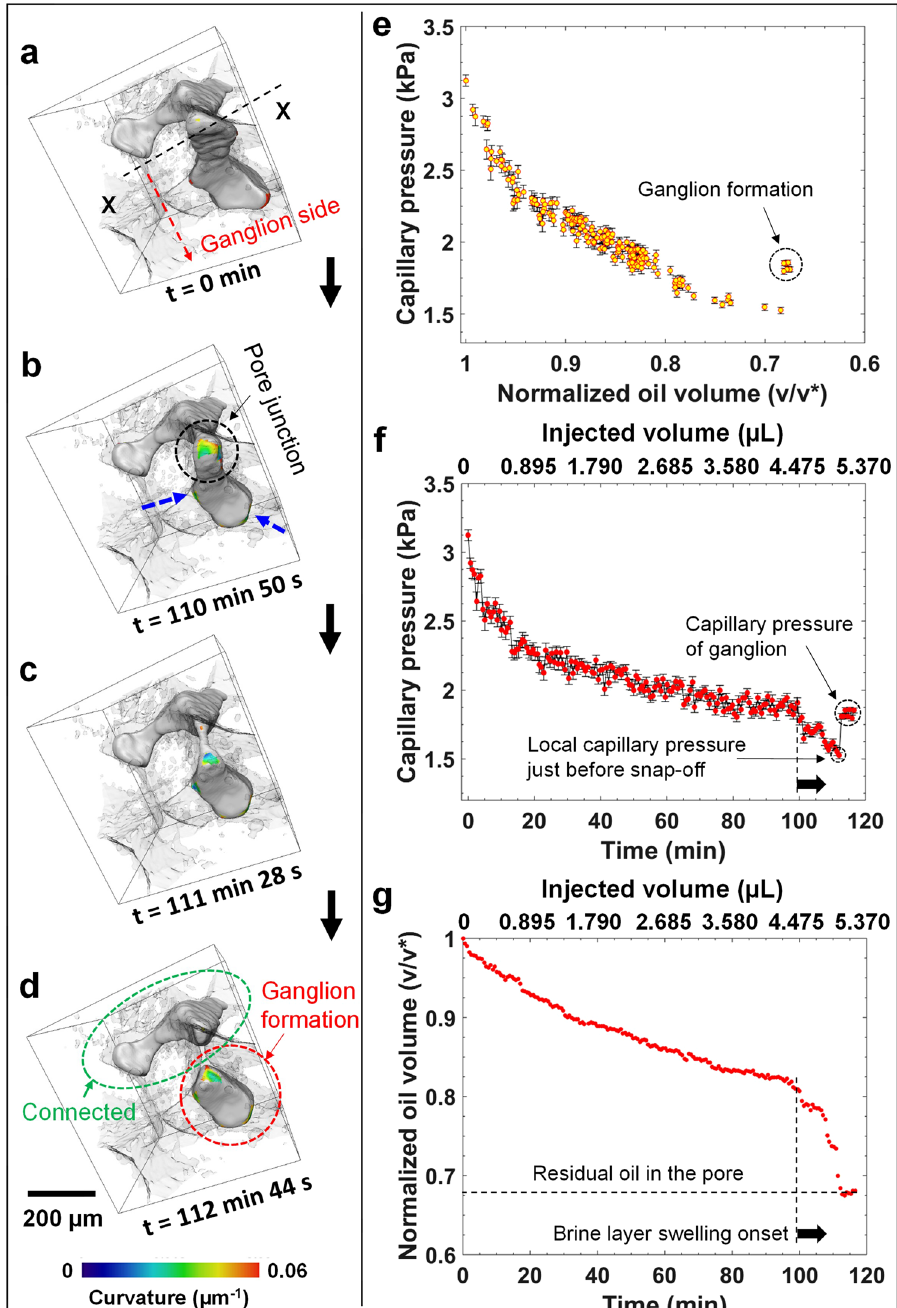
Figure 4. Snap-off during imbibition at a pore junction – Case-II. Various time steps during brine injection showing oil progression and trapping: ( a ) t = 0 min (injected volume = 0 µ L), ( b ) t = 110 min 50 s (injected volume = 4.960 µ L), ( c ) t = 111 min 28 s (injected volume = 4.988 µ L), and ( d ) t = 112 min 44 ss (injected volume = 5.045 µ L). The dashed blue arrows indicate the movement of the interface. ( e ) and ( f) Show capillary pressure as a function of normalized oil volume and time respectively. ( g ) Normalized oil volume as a function of